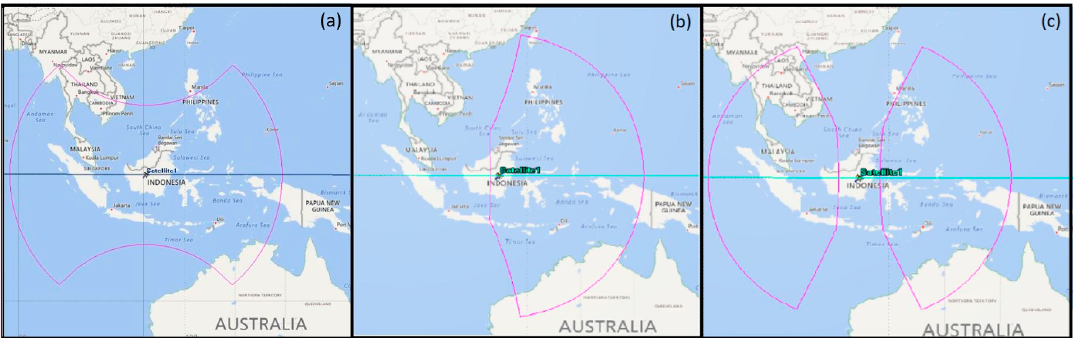
Figure 5. Typical antenna pattern of LAPAN-A2 AIS Antenna ( a ) nadir satellite attitude mode; ( b ) 45°-maneuvered; ( c ) 90°-maneuvered.